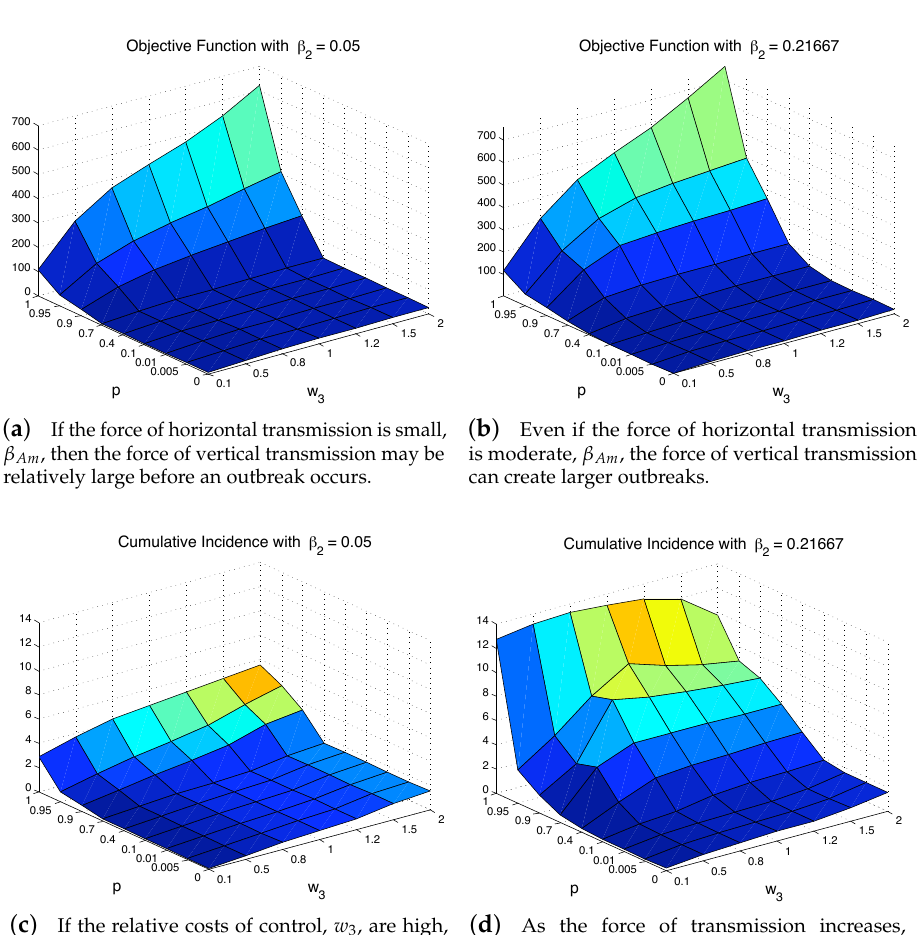
Figure 9. Regardless of whether horizontal transmission is low, left panels, or moderate, right panels, a high level of vertical transmission can create extremely large, and costly outbreaks, top panels. If the relative costs of controlling the outbreak are low, w 3 , then the epidemic can still be controlled, bottom panels. However, if the cost is high, then the outbreak will be extremely expensive and impossible to